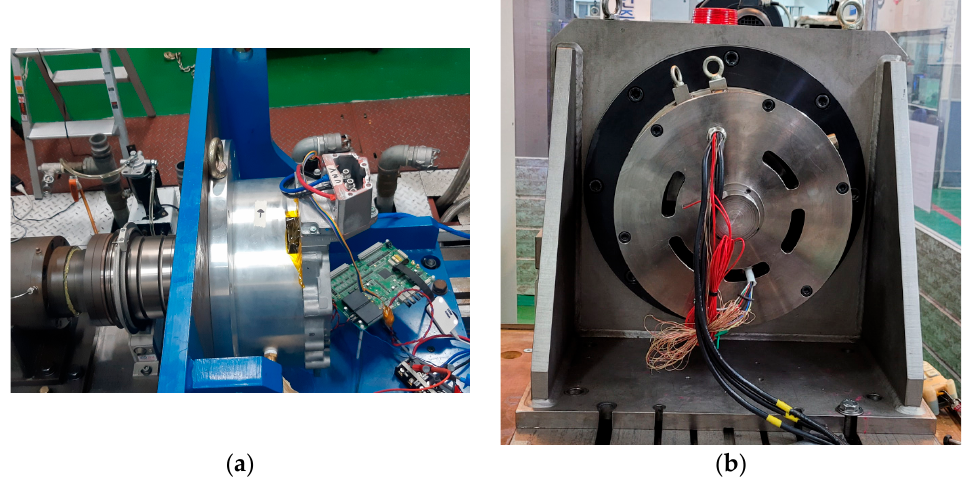
Figure 25. Photographs of the experiment on applying a diamagnetic field current to both models: ( a ) NdFeB magnet Apply conventional model, ( b ) Dy-free NdFeB magnet Apply final model.